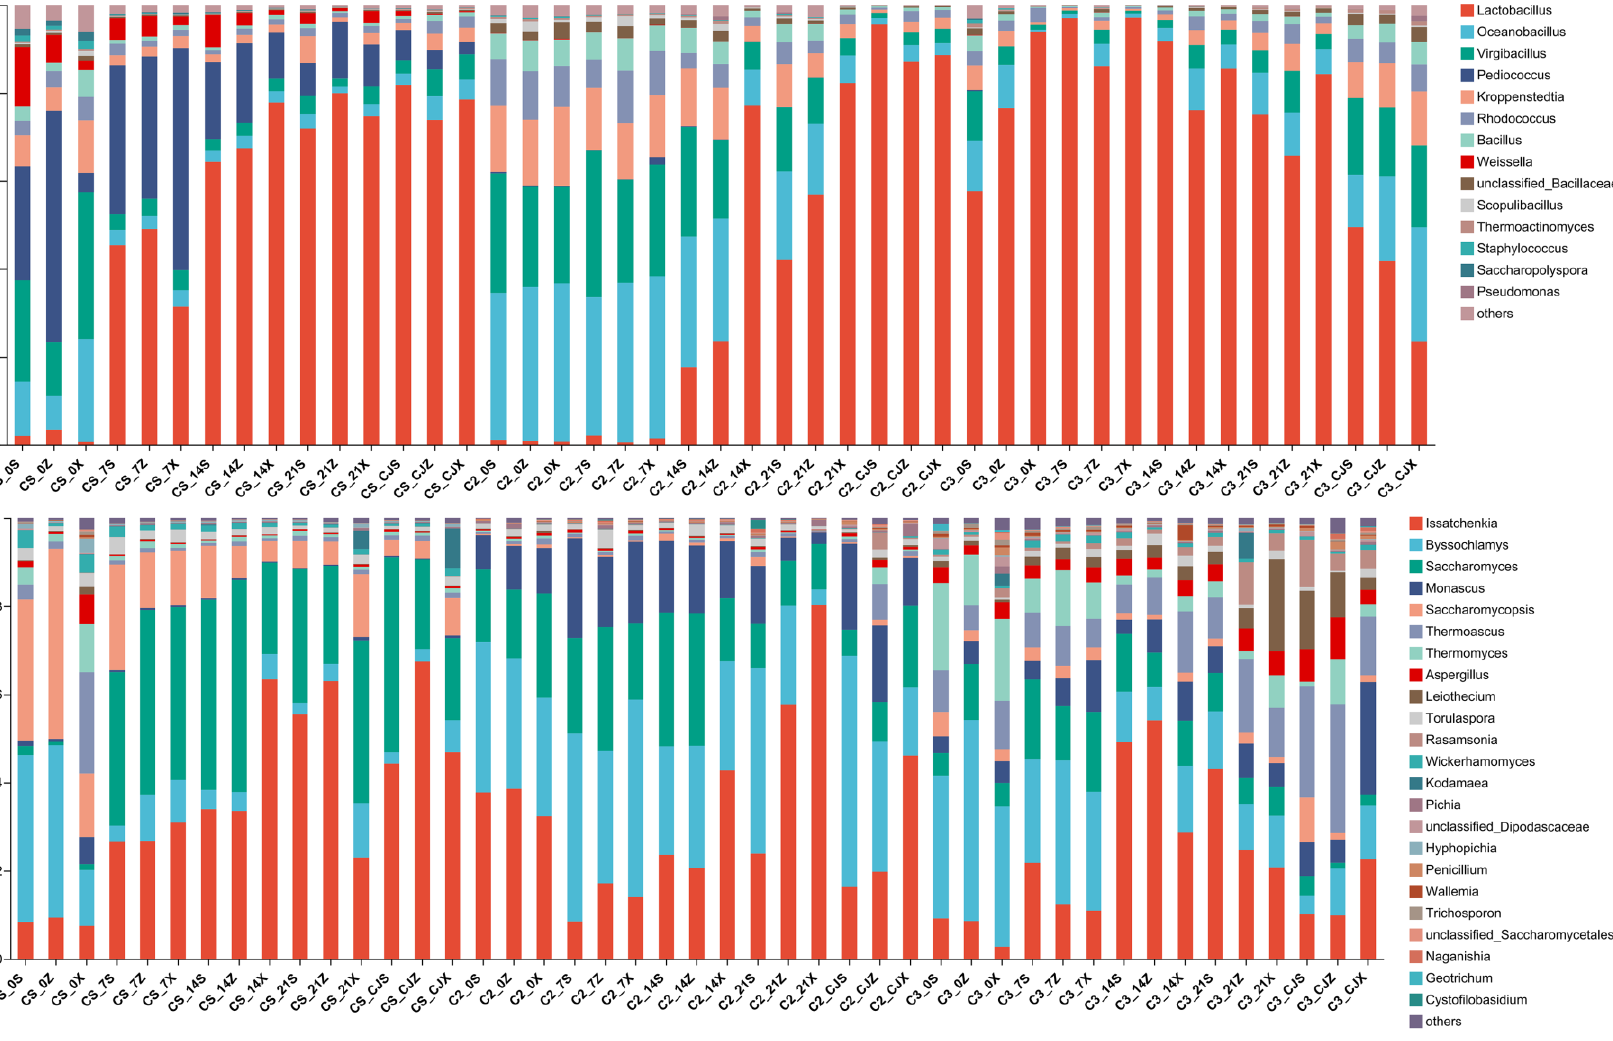
Figure 4. The microbial composition analysis of bacteria and fungi at genus level in rounds 1b, 2, and 3 of sauce-flavor Baijiu samples. ( a ) bacteria. ( b ) fungi.